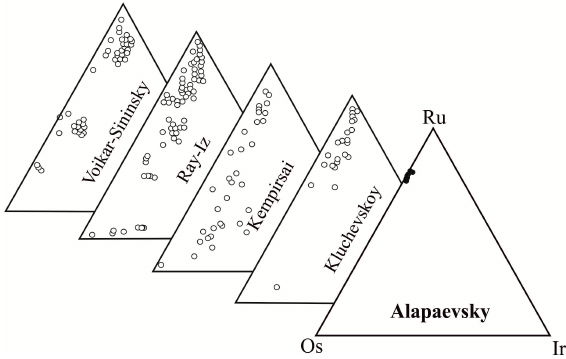
Figure 10. Back-scattered electron (BSE) image of a Ni–Fe phosphide found in the interstitial serpentine of the Bakanov Kluch chromitite.